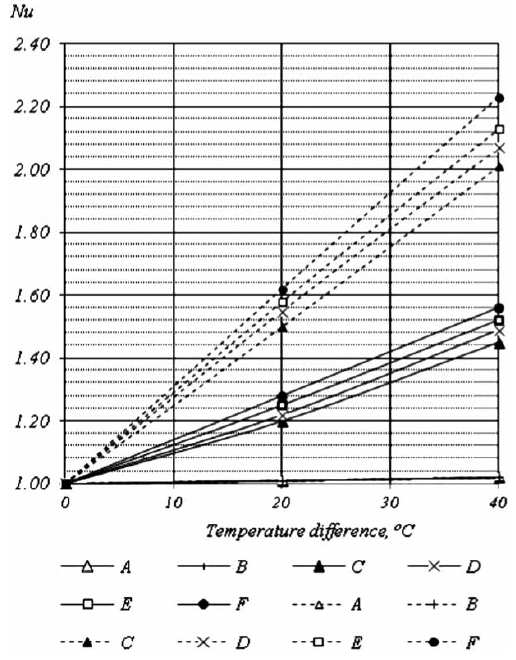
Fig. 5. The dependence of the Nu criterion in: * non- ventilated and ---- ventilated constructions on difference in temperature when small air gaps are of 5 mm thickness